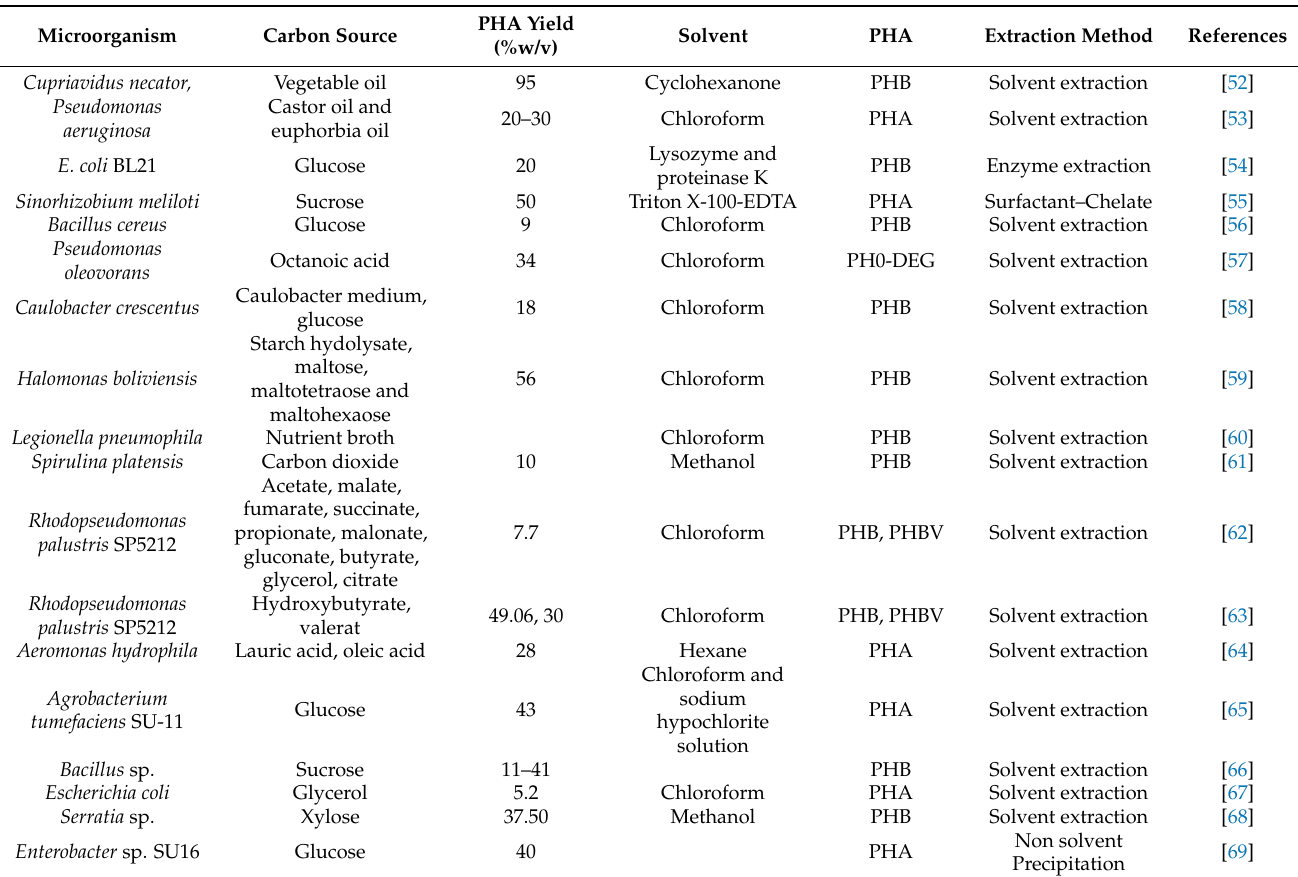
Table 1. Synthesis of PHA from various